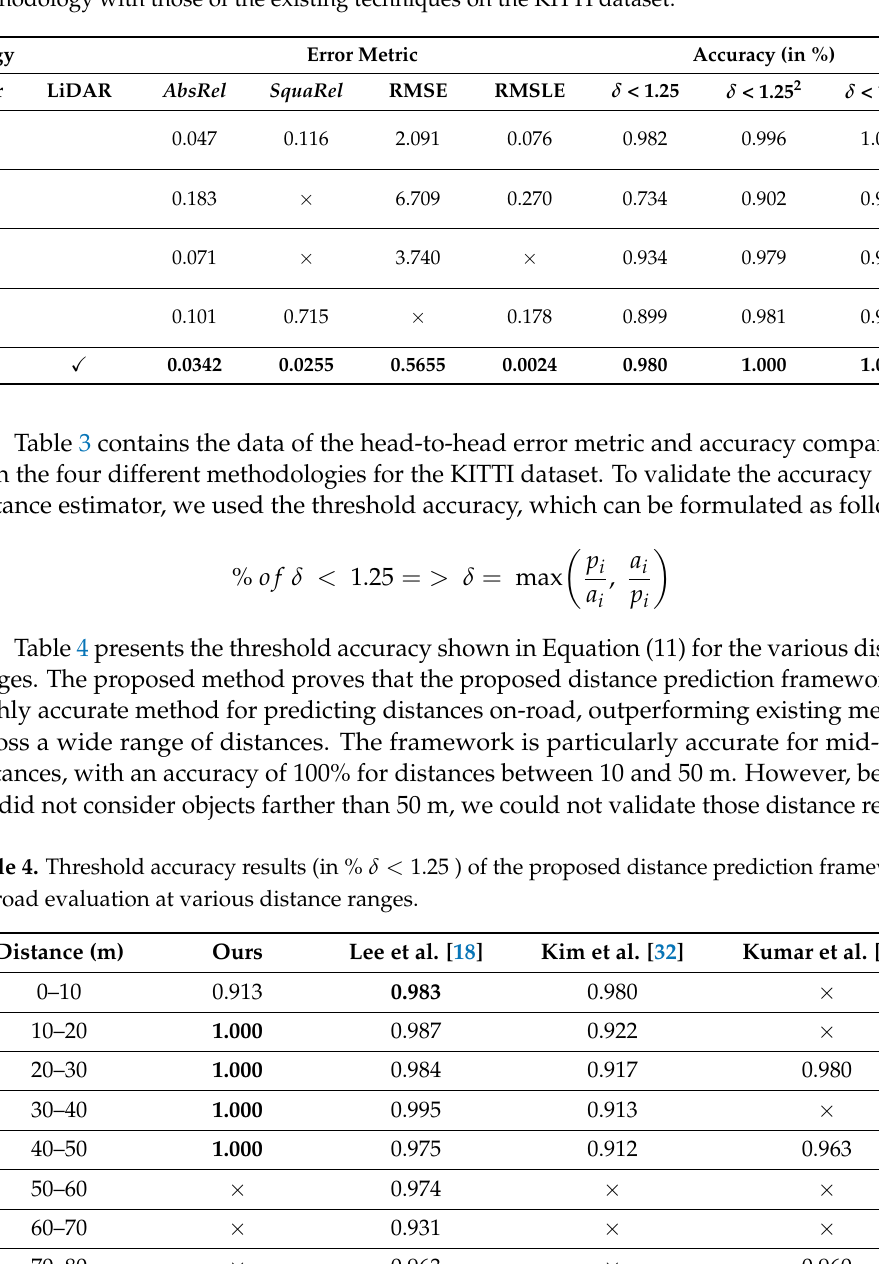
Table 3. Error metric and accuracy comparison of the quantitative performance of the proposed methodology with those of the existing techniques on the KITTI dataset.